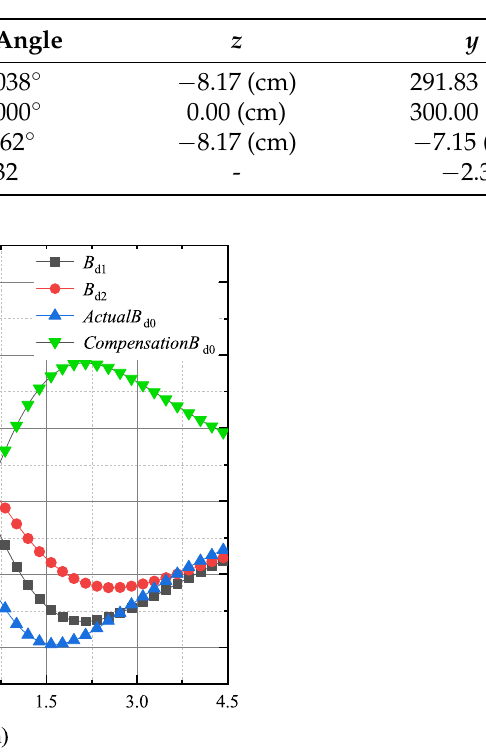
Table 3. The tracking error of the algorithm in the pitch angle case.